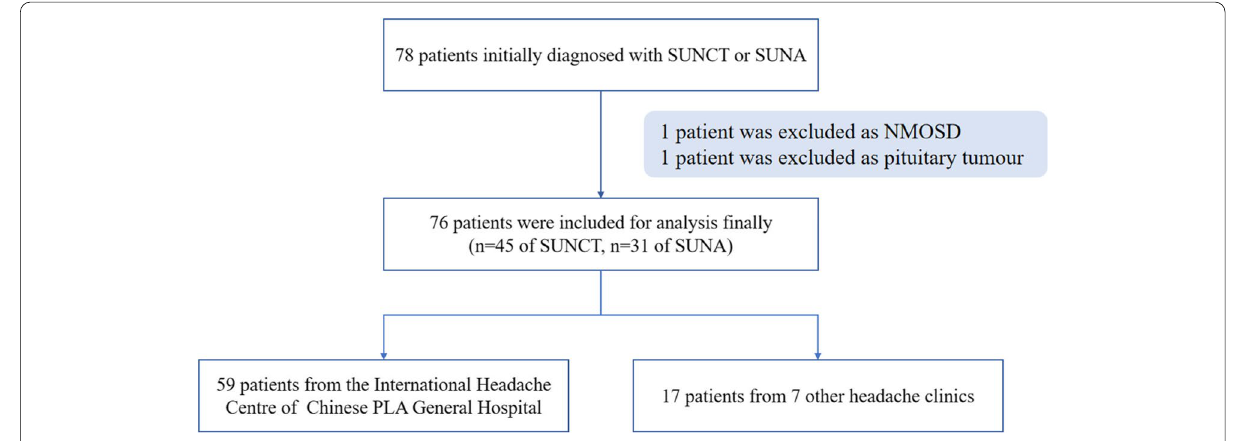
Fig. 1 Flow chart of patient